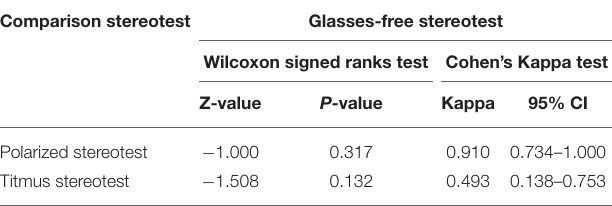
TABLE 3 | Comparative results between